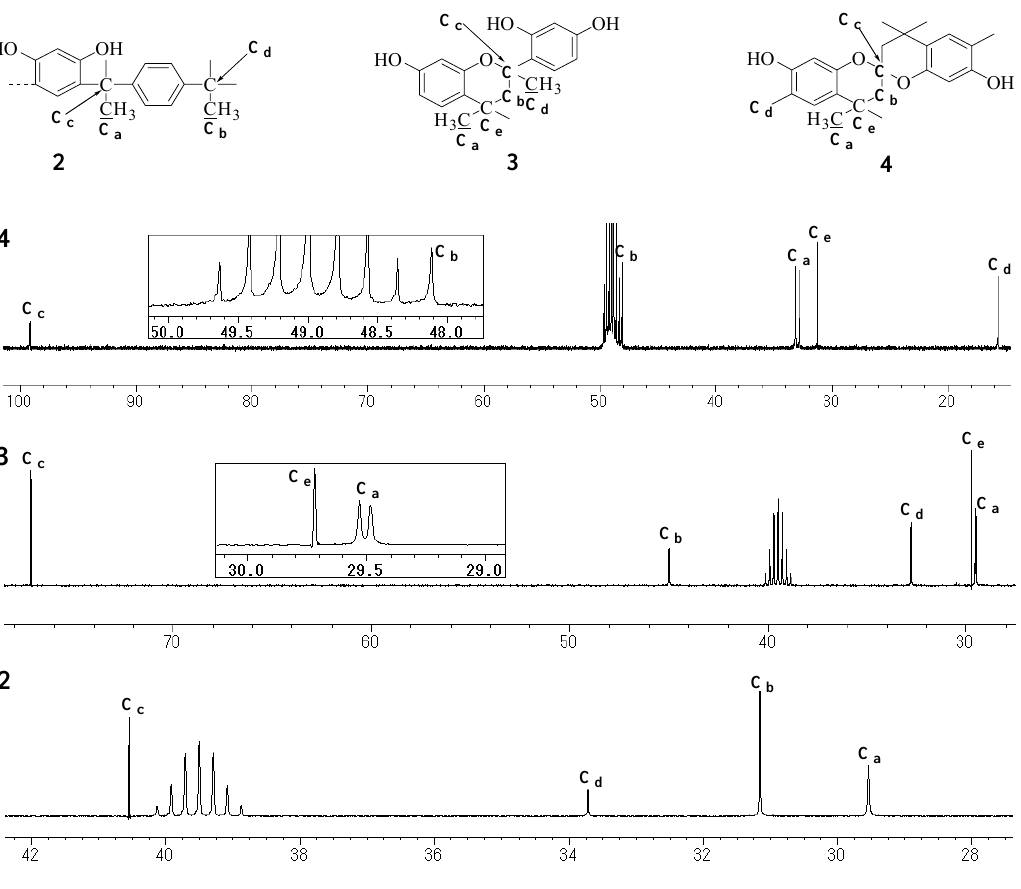
Figure 10 . 13 C-NMR spectra of 2 , 3 (DMSO, 100 MHz), and 4 (MeOH, 100